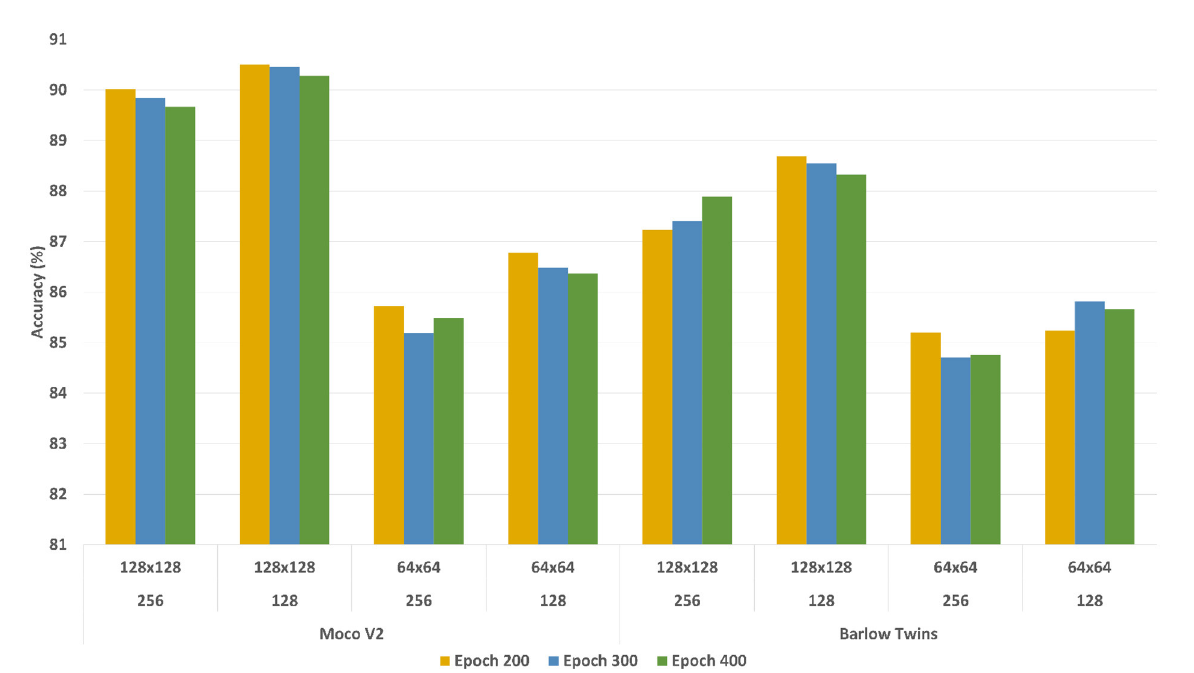
FIGURE7 Linear evaluation accuracy comparison of MoCoV2 and Barlow Twins models with different configurations of batch sizes and patch sizes. The first row of the y-axis indicates the patch sizes, the second row indicates batch sizes, and the third row indicates the